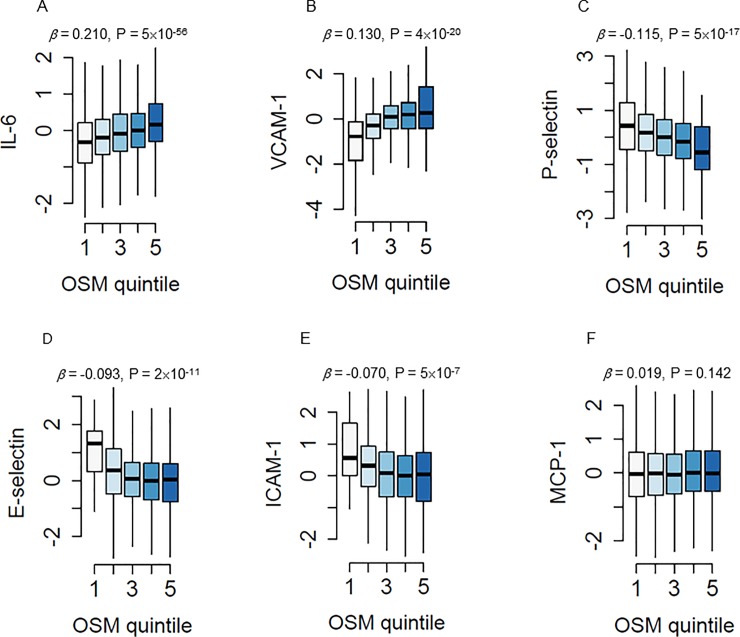
OSM is associated with endothelial activation markers.Association of serum IL-6 (A), VCAM-1 (B), P-selectin (C), E-selectin (D), ICAM-1 (E) and MCP-1 (F) levels (y-axis) with quintiles of increasing OSM serum levels (x-axis) using specific aptamers measured in 5457 subjects of the AGES cohort. Linear regression analyses were used to test for association.